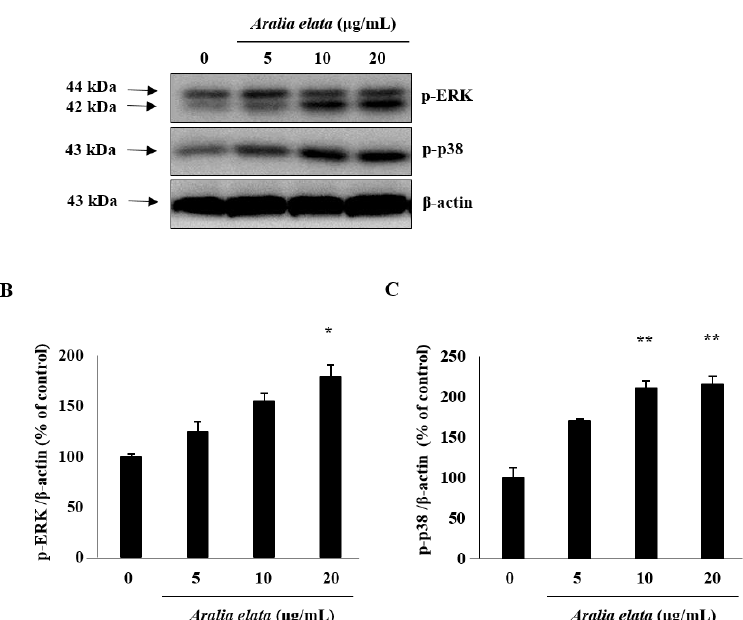
Figure 3. ERK and p38 activation by AS in HUVECs. Cells were incubated with different concentrations of AS (0 –20 μg/mL) for 24 h, lysed, and analyzed by Western blot. AS treatment for 24 h increased phosphorylated ERK and p38 levels in HUVECs. ( A ) Representative blots. ( B, C ) Quantitative analysis ( n = 3) of both p ‐ ERK/ β -actin and p ‐ p38/ β -actin. *p < 0.05, **p < 0.01.